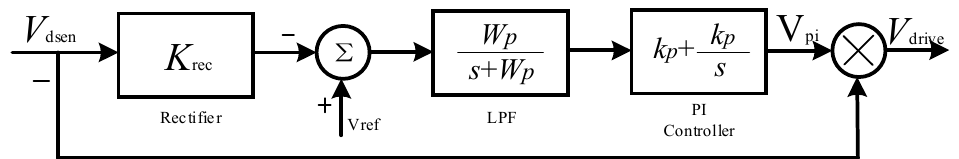
Figure 10. Topology structure of MEMS gyroscope interface circuit.